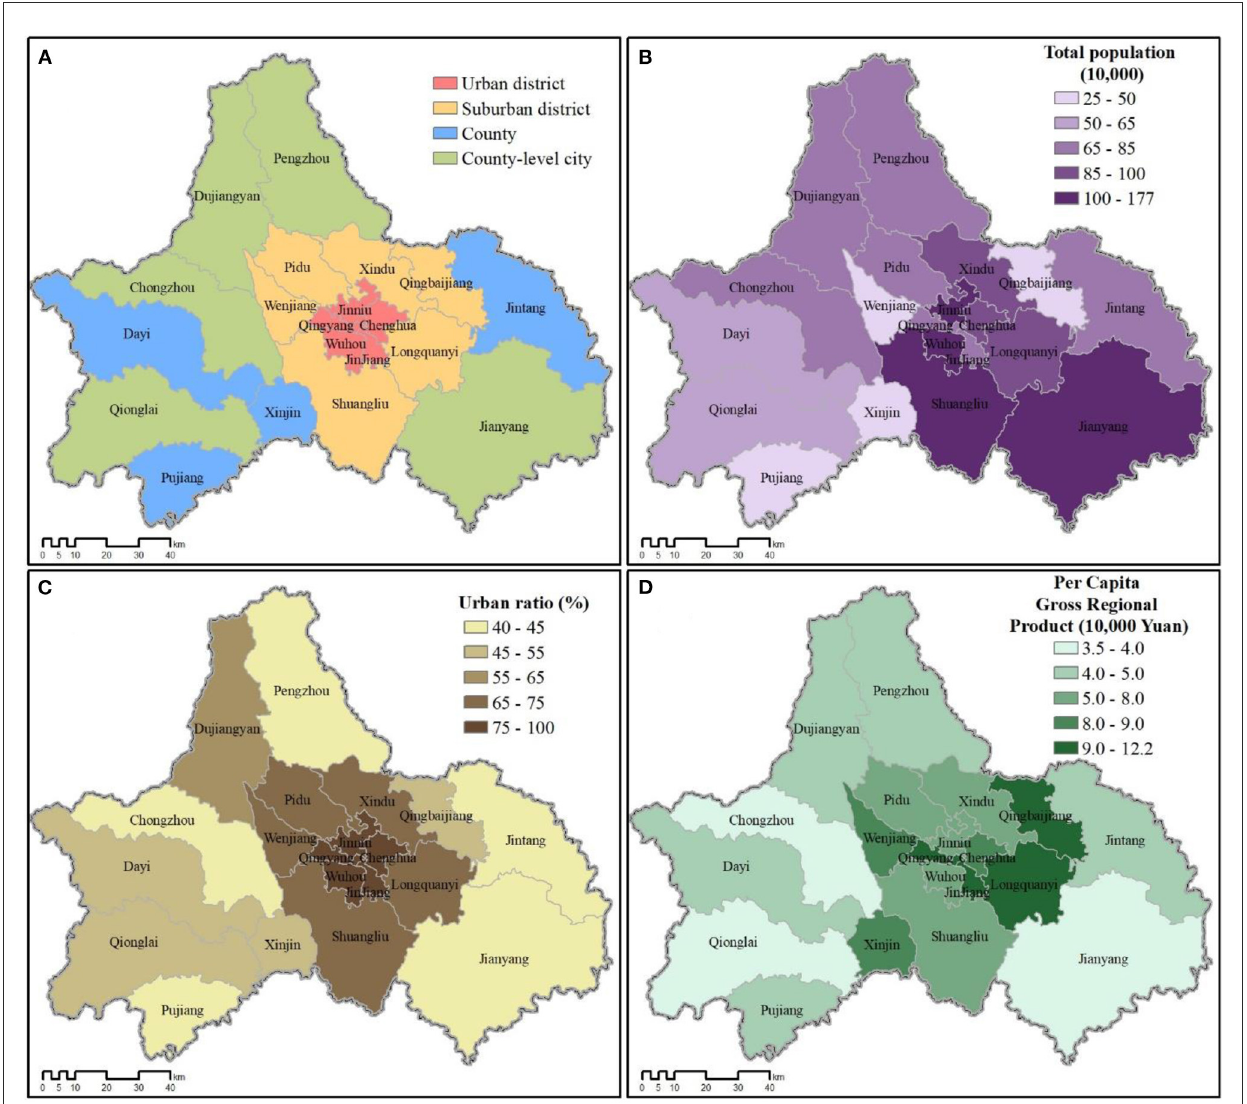
FIGURE2 (A) Four types of county-level jurisdictions comprising Chengdu city. (B) Population by jurisdiction. (C) Urban ratio (% population classified as urban). (D) Per capital income (gross regional product; GRP) by jurisdiction. Source: Sichuan Statistical Yearbook 2017 (http://web.sctjj.cn/tjcbw/tjnj/2017/